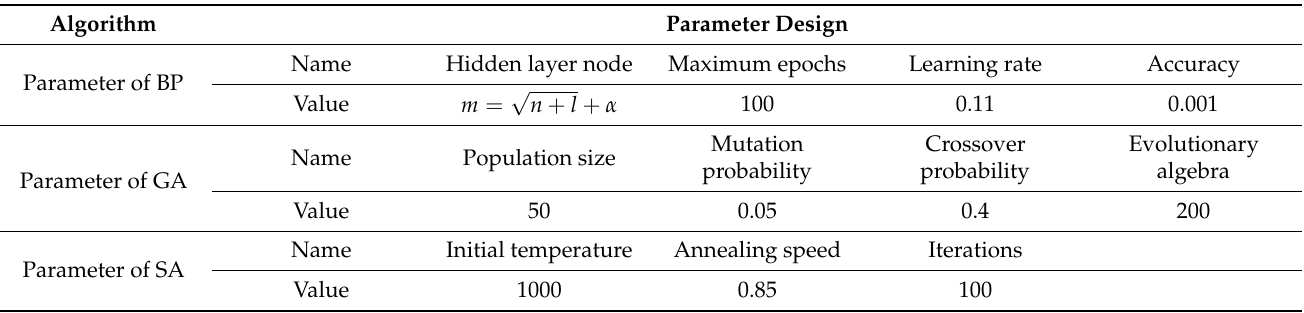
Table 3. Parameters of